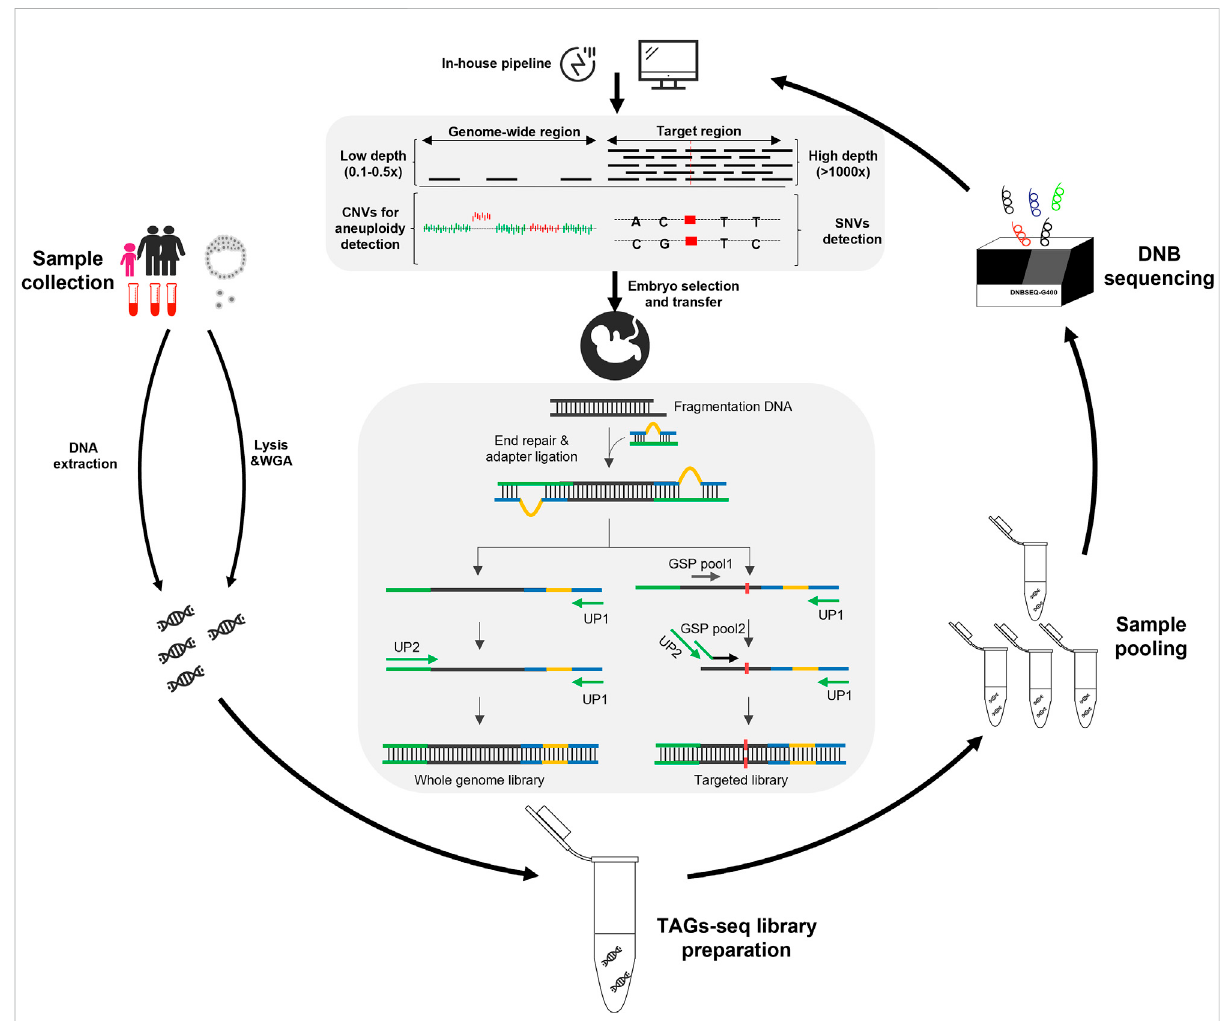
FIGURE 1 OverviewoftheTAGs-seqwork fl owforPGT-AandPGT-M.ThegDNAproductswereextractedfromthebloodsamplesofthetriofamily,while the MDA product was prepared from a few (6 – 8) trophectoderm cells of an embryo. Then the TAGs-seq library preparation and pooling were performed, followed by the sequencing on DNBSEQ-G400 platform. The monogenic disorders and genomic imbalances were analyzed by an in- house pipeline. Finally, a healthy embryo was selected to transfer according to the result of